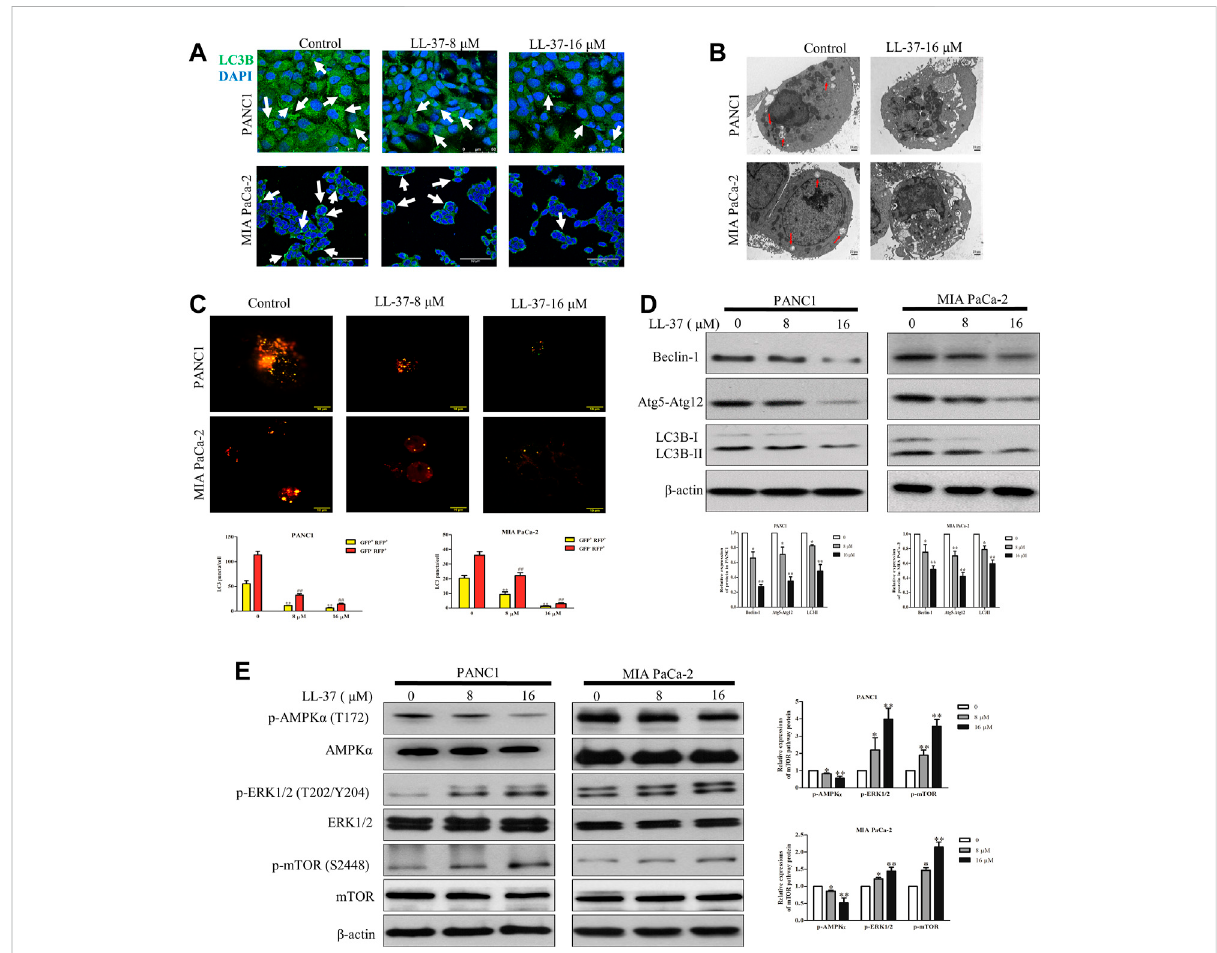
FIGURE 3 LL-37 inhibits autophagy in pancreatic cancer cells. (A) LL-37 (8 and 16 μ M) decreased the formation of autophagosomes in pancreatic cancer cells as determined using immuno fl uorescence microscopy. (B) Autophagic vacuoles in PANC1 and MIA PaCa-2 cells treated with 16 μ M LL-37 or DMSO were observed by TEM. The red arrow indicates autophagic vacuoles. (C) The autophagic fl ux in LL-37-treated PANC1 and MIA PaCa-2 cells wastestedusingtheAutophagyTandemSensorRFP-GFP-LC3B.Representativeimageswerephotographedunderaconfocalmicroscope.The average numbers of yellow and red LC3B dots per cell are shown, **p < 0.01 vs. control of yellow dots, ##p < 0.01 vs . control of red dots. (D) The levels ofautophagymarkersLC3II,Atg5 – Atg12 andBeclin-1 inPANC1and MIAPaCa-2 cellsweremeasuredbywesternblottingafter treatment with LL-37 for 24 h. (E) The mTOR pathway involved in the inhibitory effect of LL-37 on autophagy was determined by western bloting. Cells treated with DMSO were used as negative controls. Three independent experiments were each performed in triplicate. Representative protein bands are